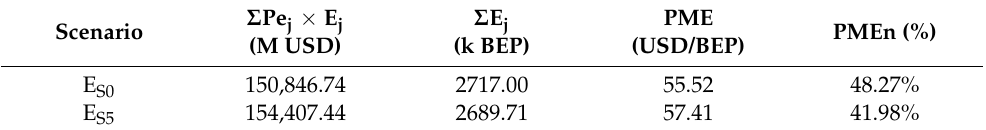
Table 21. Mean price of